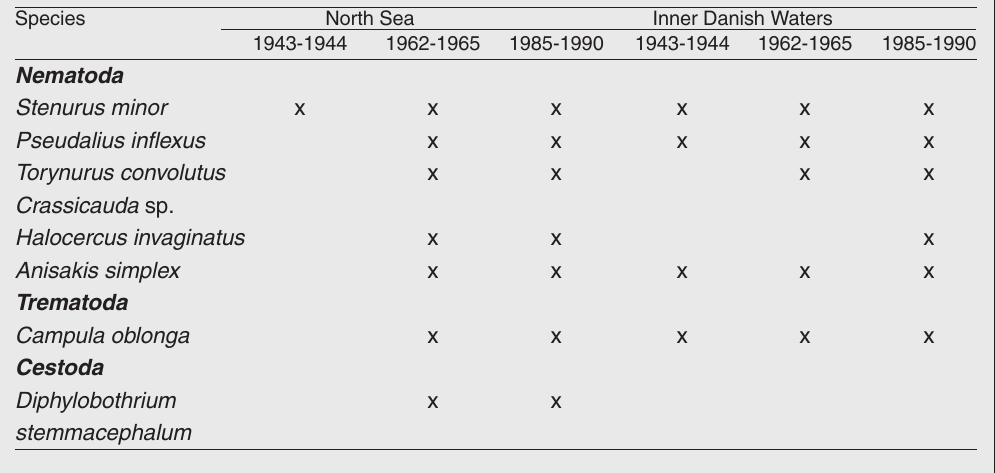
Table 8. Parasites found in Danish harbour porpoises 1943-90 (citations in